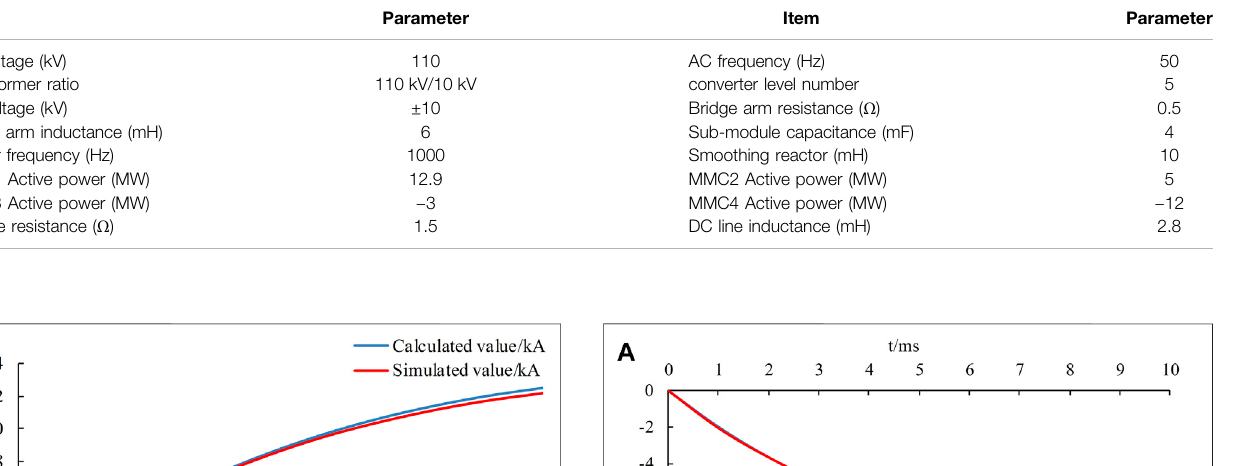
TABLE 1 | The system parameters of four-terminal ring grid DC distribution system.